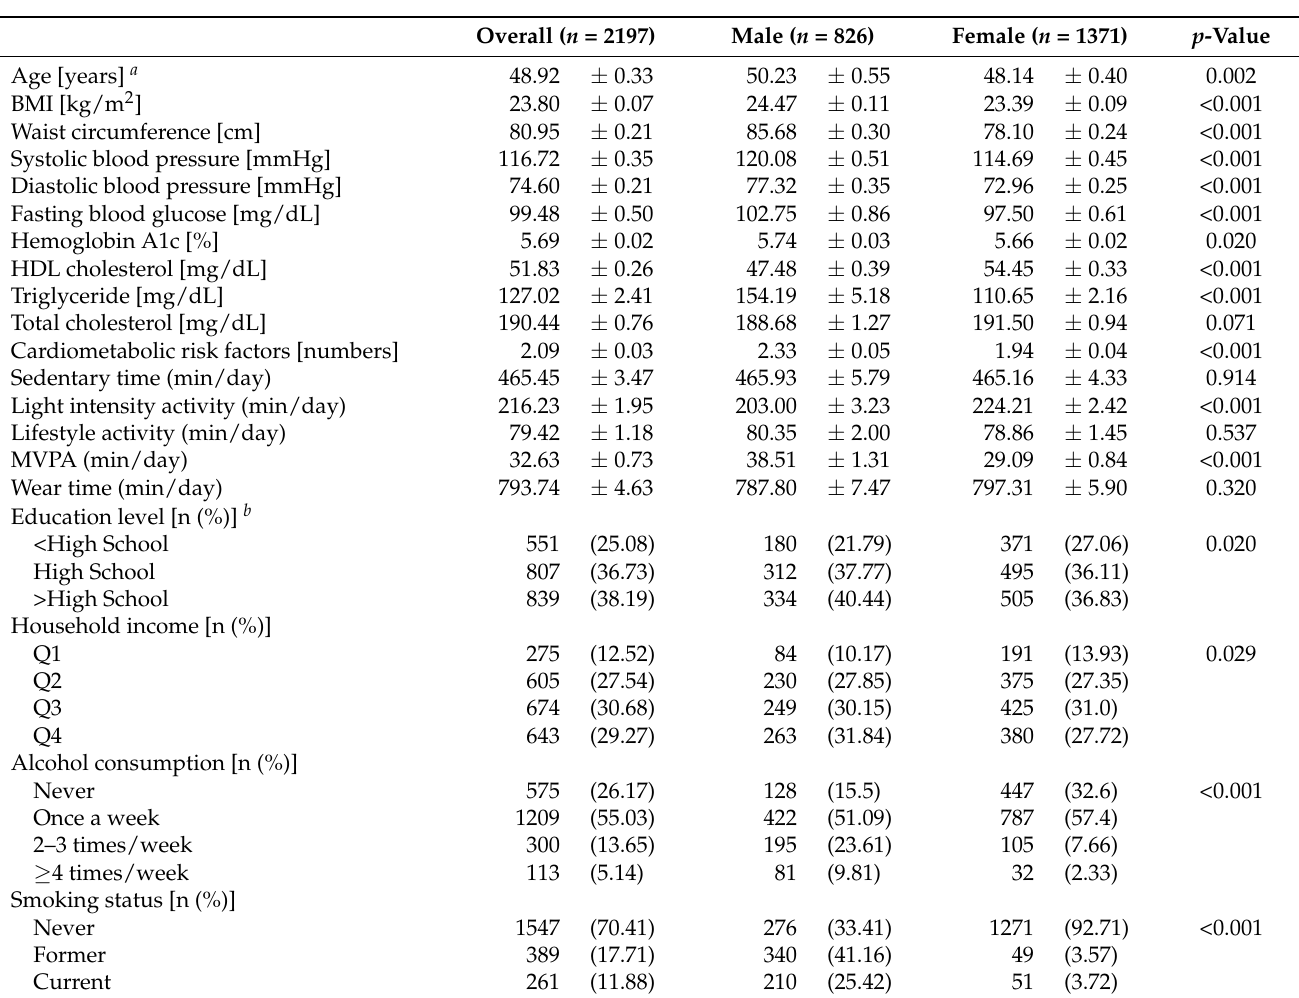
Table 1. Participant characteristics.